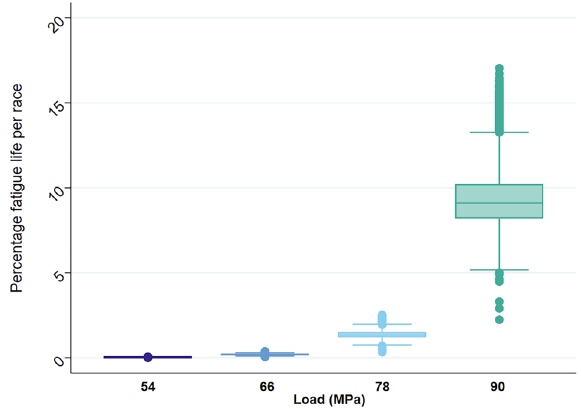
Figure 1. Box-plot showing the percentage fatigue life accrued in 25,234 Thoroughbred race starts in Tasmania, Australia when scaled to pre-determined experimental joint